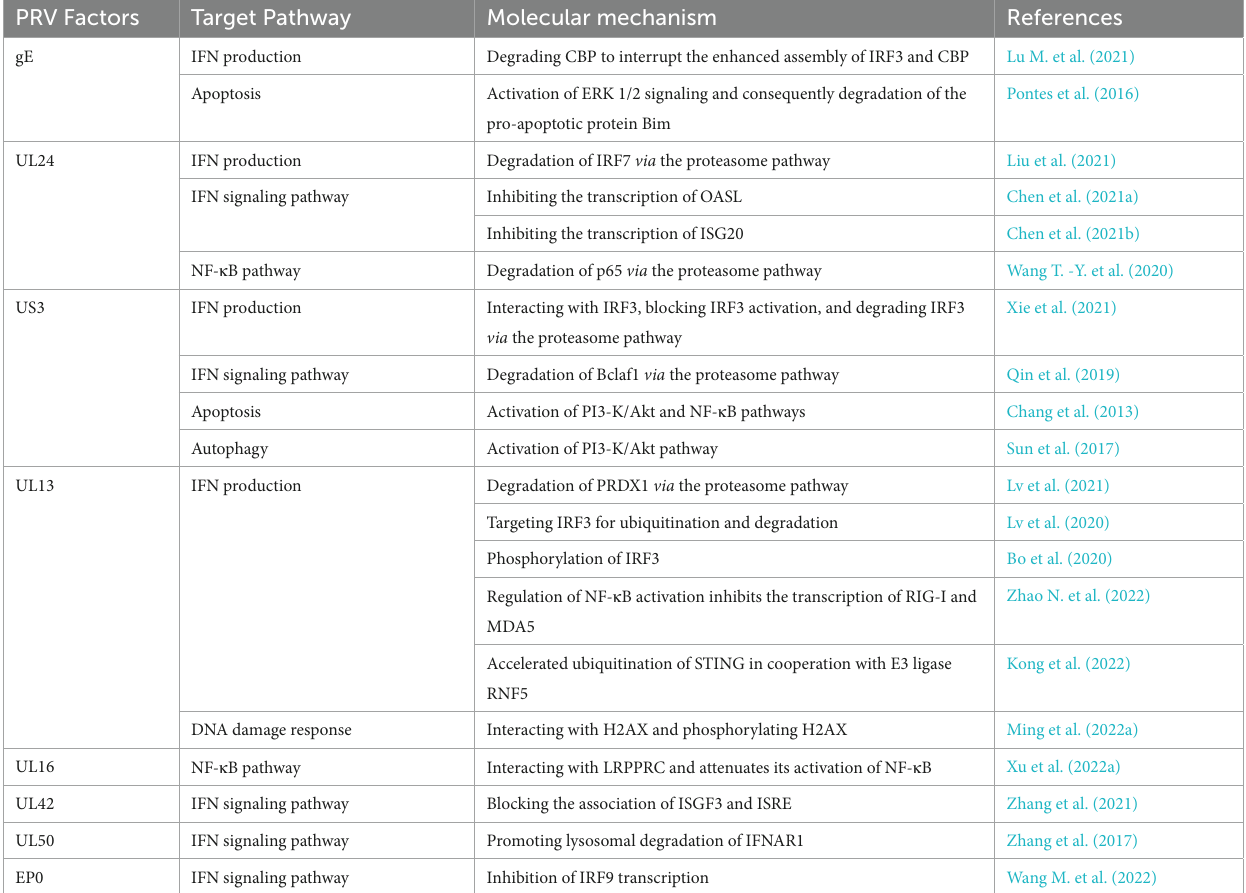
TABLE 1 PRV factors interact with the host’s innate immune